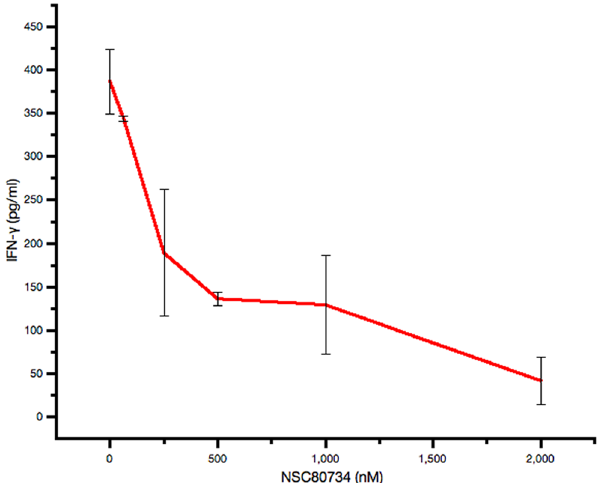
Figure 5. Dose dependent inhibition of IFN- γ Production. Human IL-18 bioassay for the detection of secreted IFN- γ at a constant concentration of hIL-18. Inhibition curves obtained with increasing concentration of NSC80734 and a cell concentration of 1 × 10 6 cells ml − 1